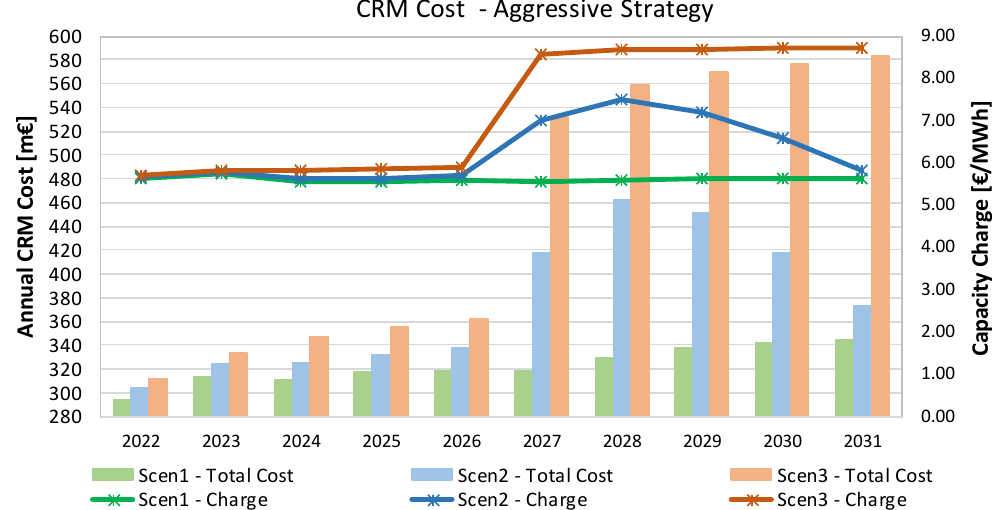
Figure 11. CRM annual cost and capacity charge–aggressive strategy.